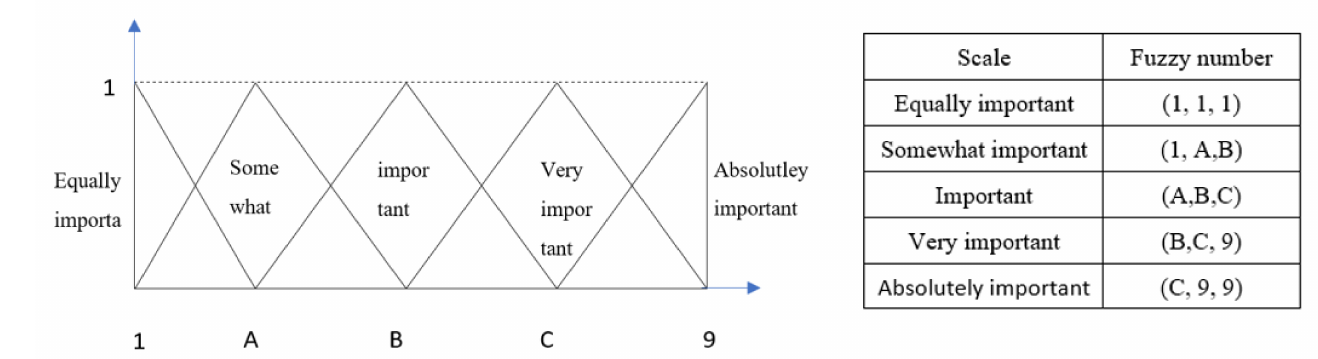
Figure 5. Semantic variables scale.